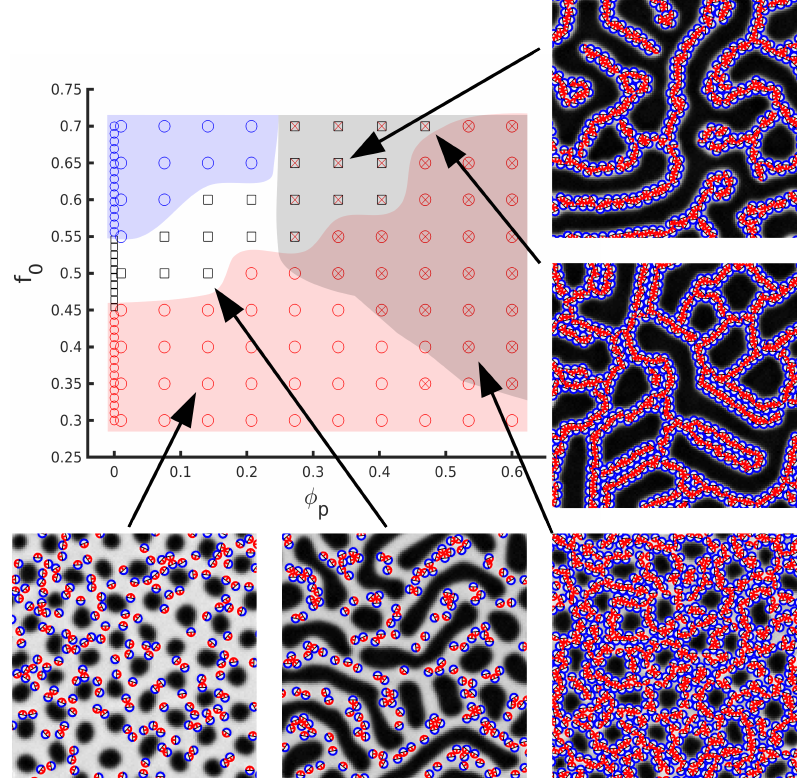
Figure 21. Phase behaviour of the BCP in the presence of a concentration φ p of JNP with ψ ∆ ψ = 1.0. Symbols are as follows: circles stand for cylindrical phase with colour determining the 0 majority (red circles indicate white monomer as the majority and blue circles indicate the opposite); lamellar phase is denoted by black squares; a further cross indicates a high degree of particle-to- particle orientational order. Reprinted with permission from Ref. [171] Copyright 2019 Royal Society of